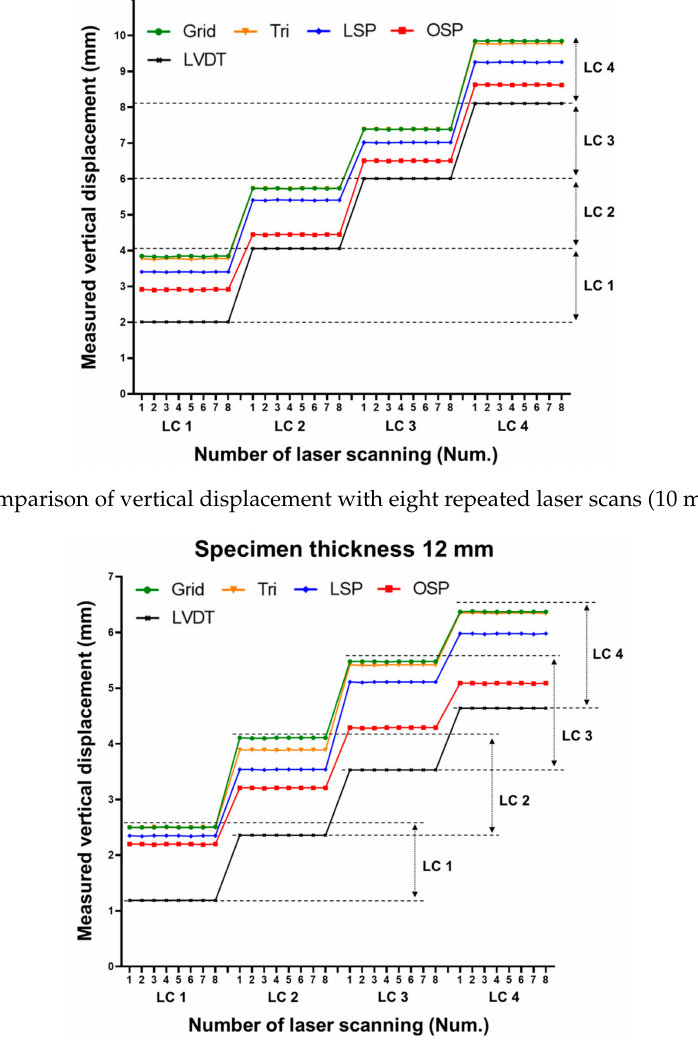
Figure 15. Comparison of vertical displacement with eight repeated laser scans (12 mm